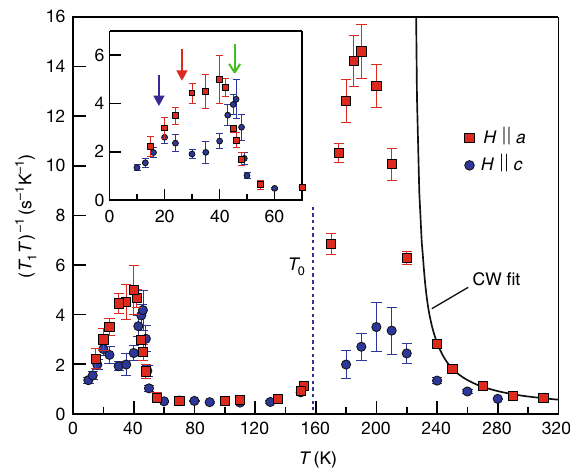
Fig. 3 Fe spin fl uctuations. Temperature dependence of the 75 As spin – lattice relaxation rate divided by temperature ( T 1 T ) − 1 measured at 15 T. The error bars re fl ect the uncertainty in the fi tting procedure. At high temperatures, ( T 1 T ) − 1 is well described by a Curie – Weiss (CW) law (solid line). Below ~240 K, it deviates from the diverging behavior and drops at lower temperatures, forming a large peak centered at ~190 K. At low temperatures below 120 K, ( T 1 T ) − 1 reaches a constant value comparable to that observed at the high temperature limit, implying that the spin fl uctuations are completely gapped out. ( T T ) − 1 sharply turns up at ~50 K, 1 indicating critical slowing down of spin fl uctuations toward a magnetic order. In the inset, T N ~ 45 K (green arrow) was identi fi ed from the sharp peak observed for H || c . ( T 1 T ) − 1 drops at T c , determined by the resistivity measurements under H || ab (red arrow) and H || c (blue arrow), microscopically probing bulk superconductivity in the magnetically